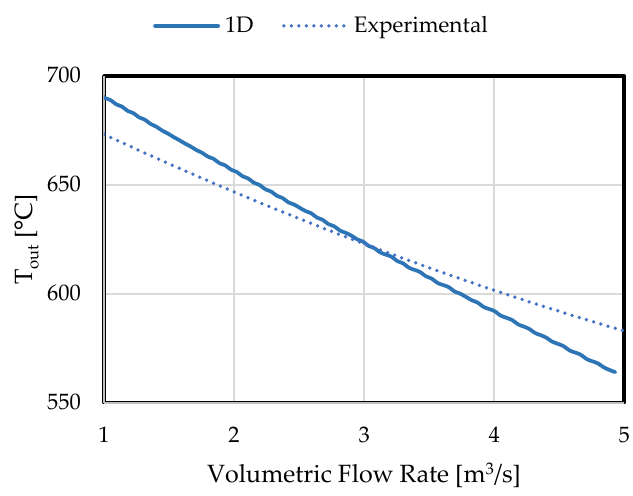
Figure 10. Results from receiver validation.